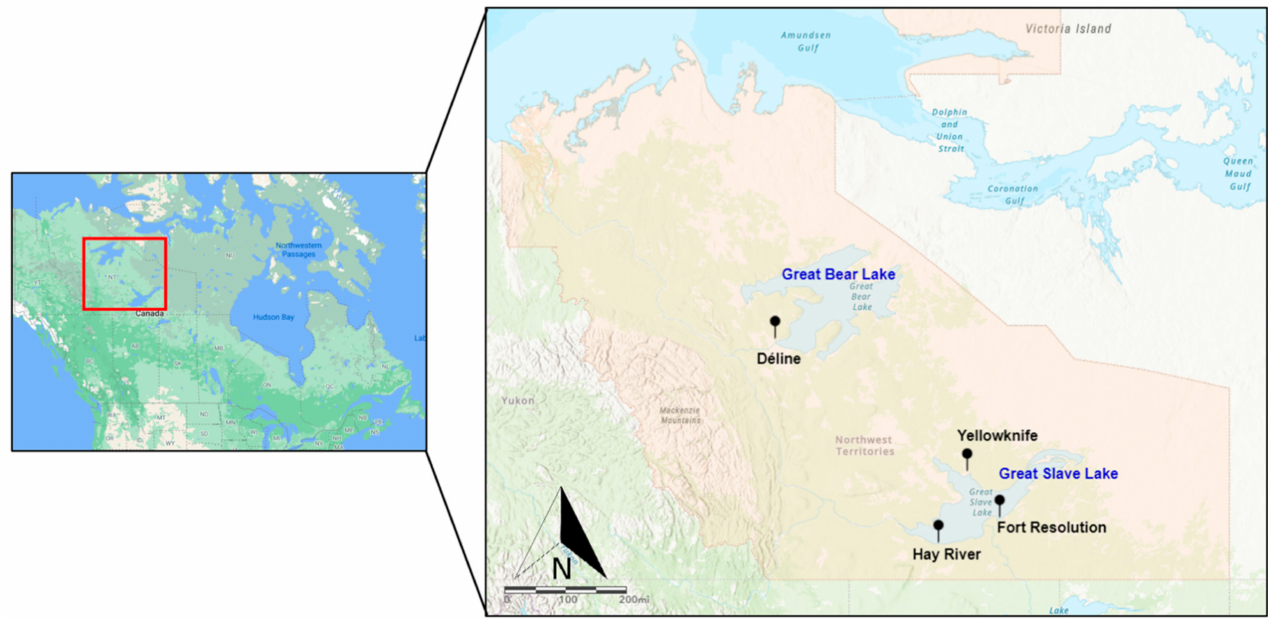
Figure 1. Location of each study region (D é line, Fort Resolution, Hay River, and Yellowknife) in relation to Great Bear and Great Slave Lake in the Northwest